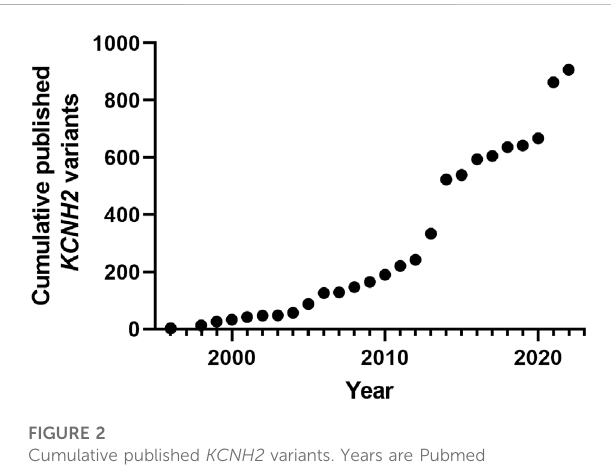
FIGURE 2 Cumulative published KCNH2 variants. Years are Pubmed publication years. The two major increases correspond to high- throughput studies, the fi rst focusing on membrane traf fi cking (Anderson et al., 2014), and the second focusing on ion channel activity with automated patch-clamp experiments (Ng et al., 2020).